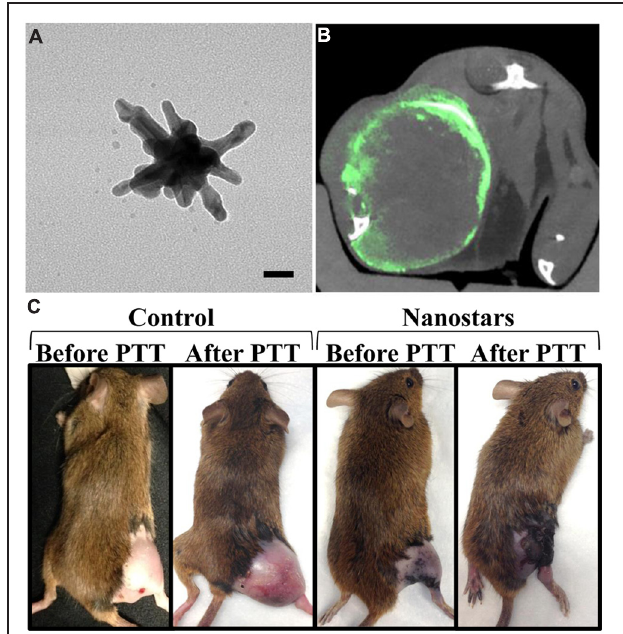
FIGURE 12 | Theranostic gold nanostars for micro-CT imaging and photothermal therapy. (A) TEM image of gold nanostar (scale bar – 20 nm). (B) Micro-CT axial section through the soft tissue sarcoma on a mouse hindlimb following gold nanostar injection. Green represents gold concentration (windowed from 2 to 10 mg/mL). (C) Photothermal therapy after injection of either gold nanostars or saline. The mice receiving gold nanostars showed complete remission of their sarcoma, while the control mice had continued rapid tumor